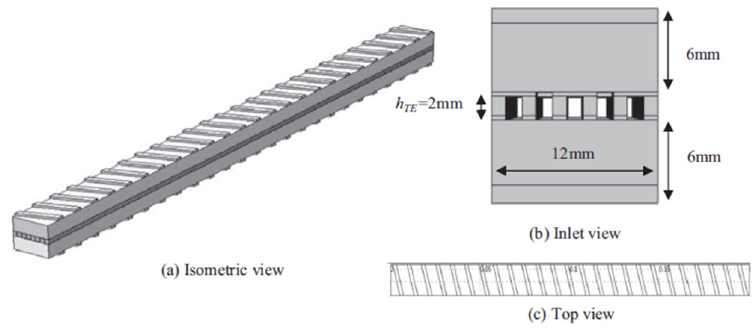
Figure 21. Channel with rotated fins. Reprint with permission [94]; Copyright 2021, Elsevier.